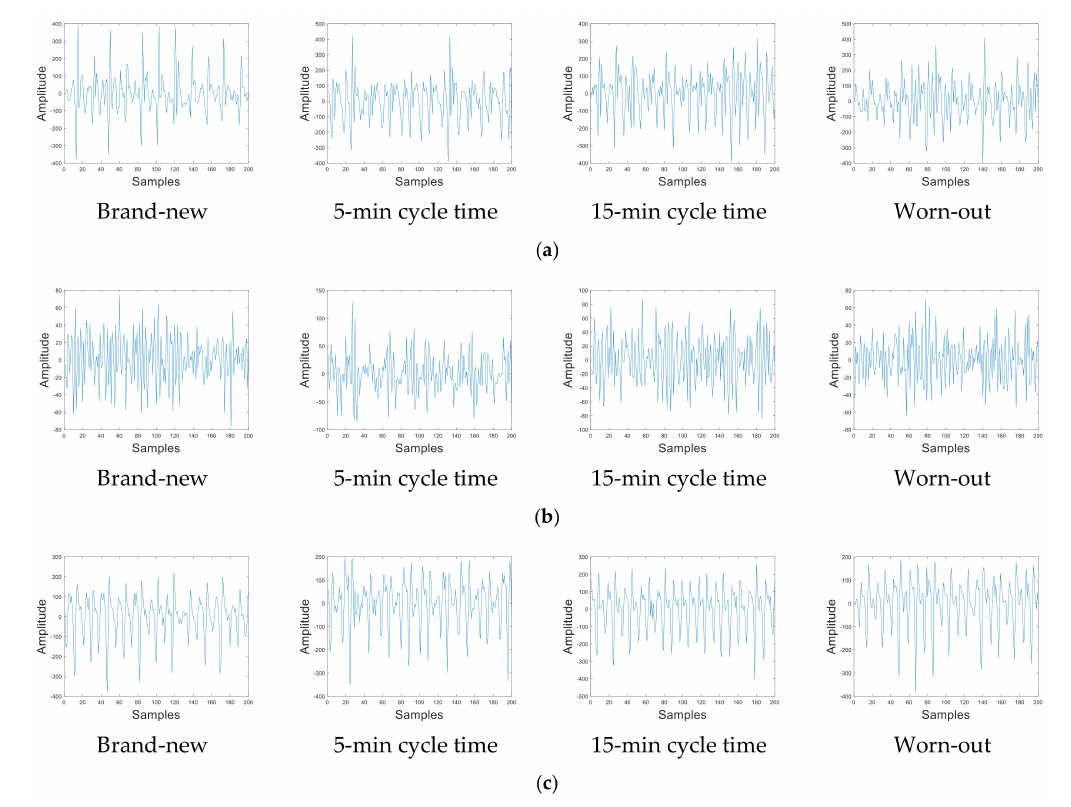
Figure 16. Vibration signals: ( a ) X-axis, ( b ) Y-axis and ( c ) Z-axis.